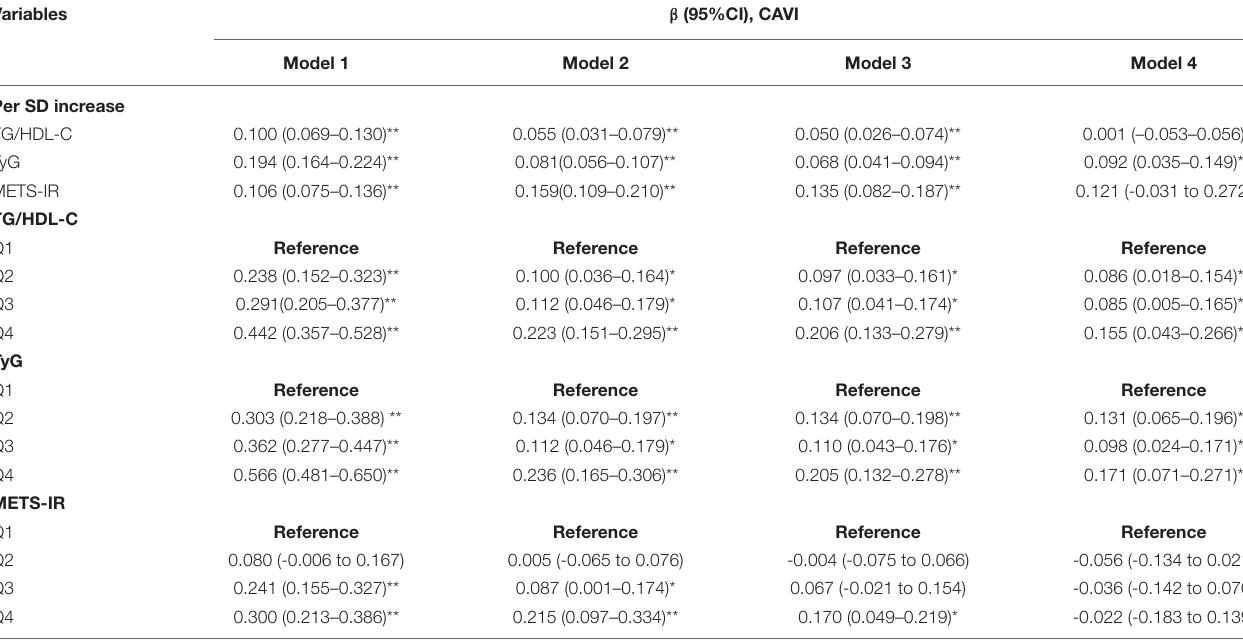
TABLE 3 | Linear regression analyses for the association between non-insulin-based IR indices and CAVI.